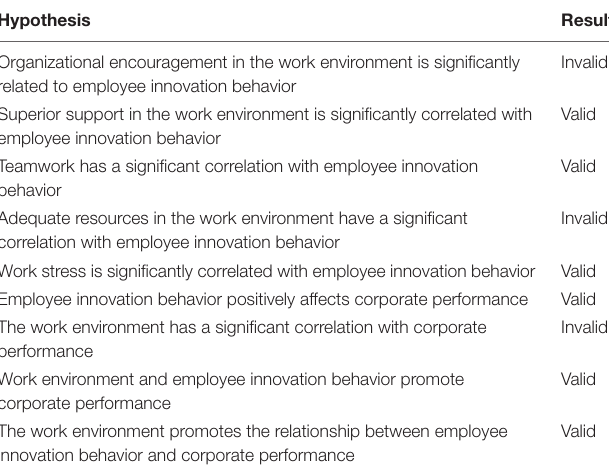
TABLE 8 | Hierarchical regression analysis